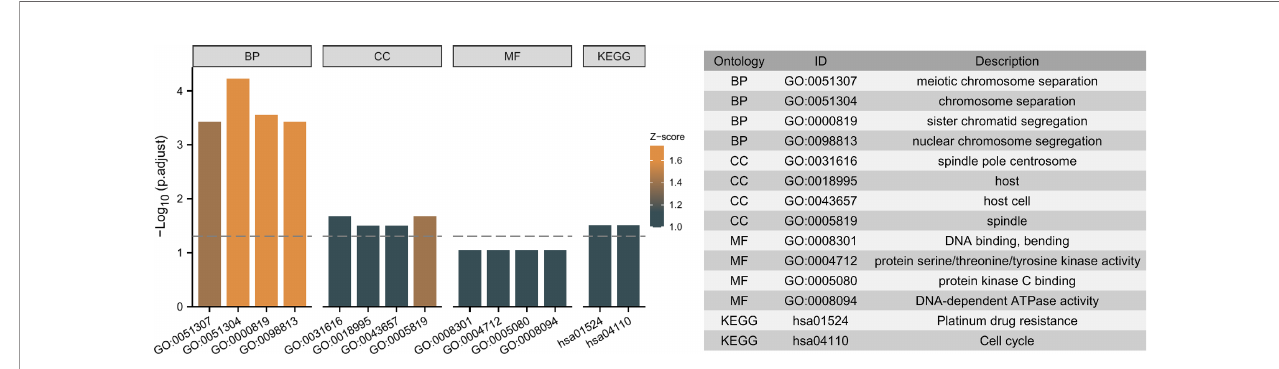
FIGURE 9 | Top ten representative pathways related to the 5 independent prognostic genes in GO and KEGG